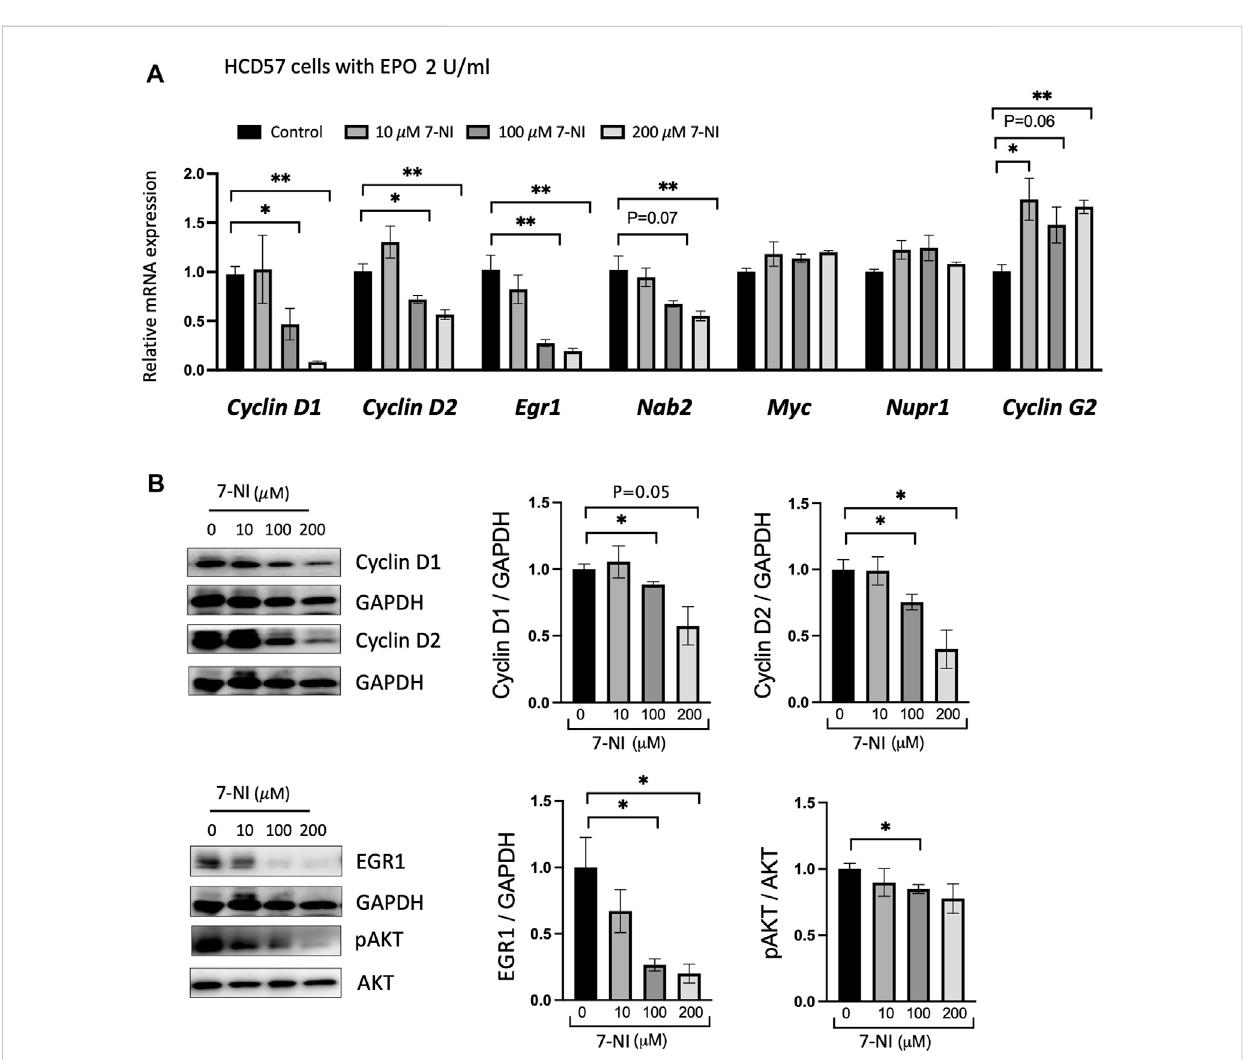
FIGURE 4 nNOS and cell cycle-associated gene expression in EPO-dependent proliferating erythroid cells. Treatment with nNOS inhibitor altered cell cycle- associated geneexpressioninHCD57 cells. (A) Geneexpression wasassessed byquantitative RT-PCRanalysisforcell cycle-associatedgenes, CyclinD1, CyclinD2,Egr1,Nab2,Myc,Nupr1 and CyclinG2 inHCD57cellsculturedwithEPO(2 U/mL)andincreasingconcentrationsofnNOSinhibitor7-NIat0,10, 100 and 200 μ M, and harvested at day 4 ( n = 3/group). (B) Protein expression of Cyclin D1, Cyclin D2, EGR1, pAKT (Ser473), AKT and GAPDH as control was assessed by Western blotting ( n = 3 – 4/group). (Indicated are p p < 0.05, and pp p <